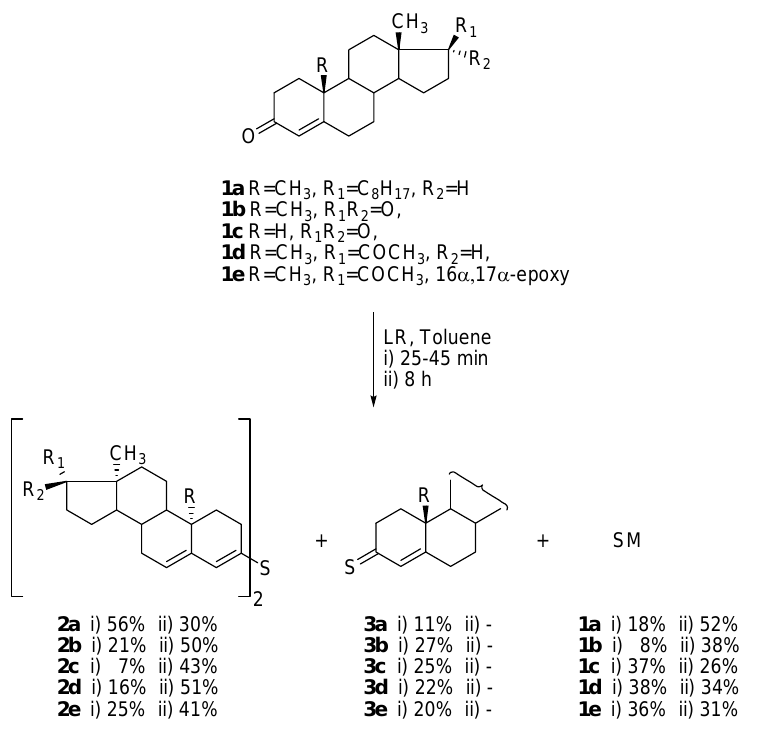
Scheme 1. Thionation of 1a - e with LR in